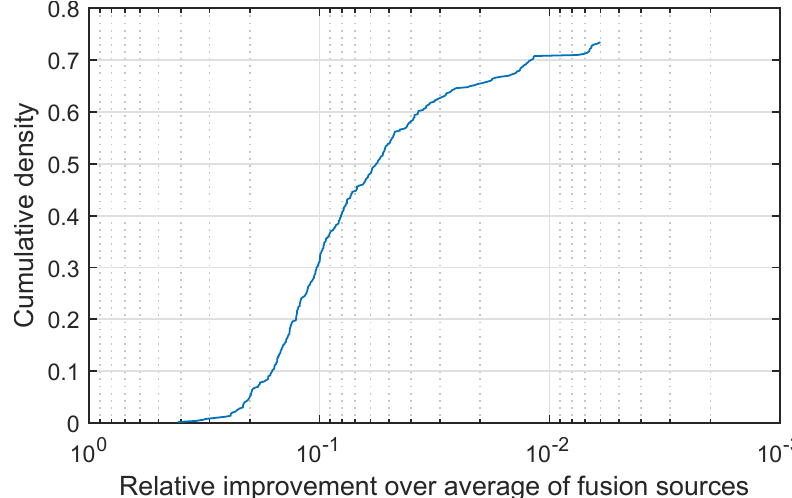
Figure 6. Car accident fatality prediction: relative improvement in the correct information source identification of the proposed quadratic mean-based fusion over linear fusion, as the corresponding cumulative distribution function.